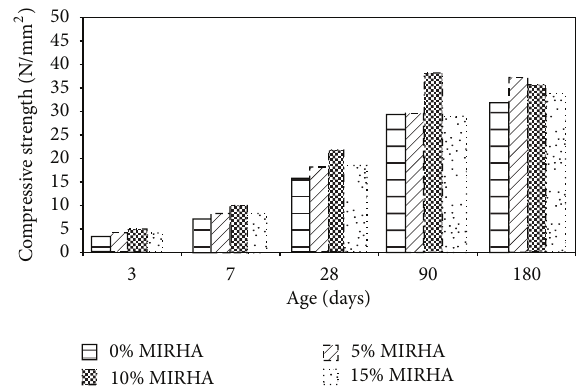
Figure 3: The compressive strength development of foamed con- crete.